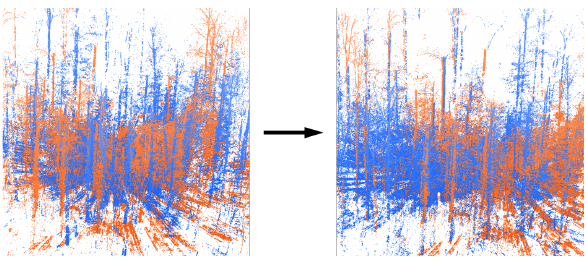
Figure 5. Registration results for point cloud pair s2-s5 of Trees dataset